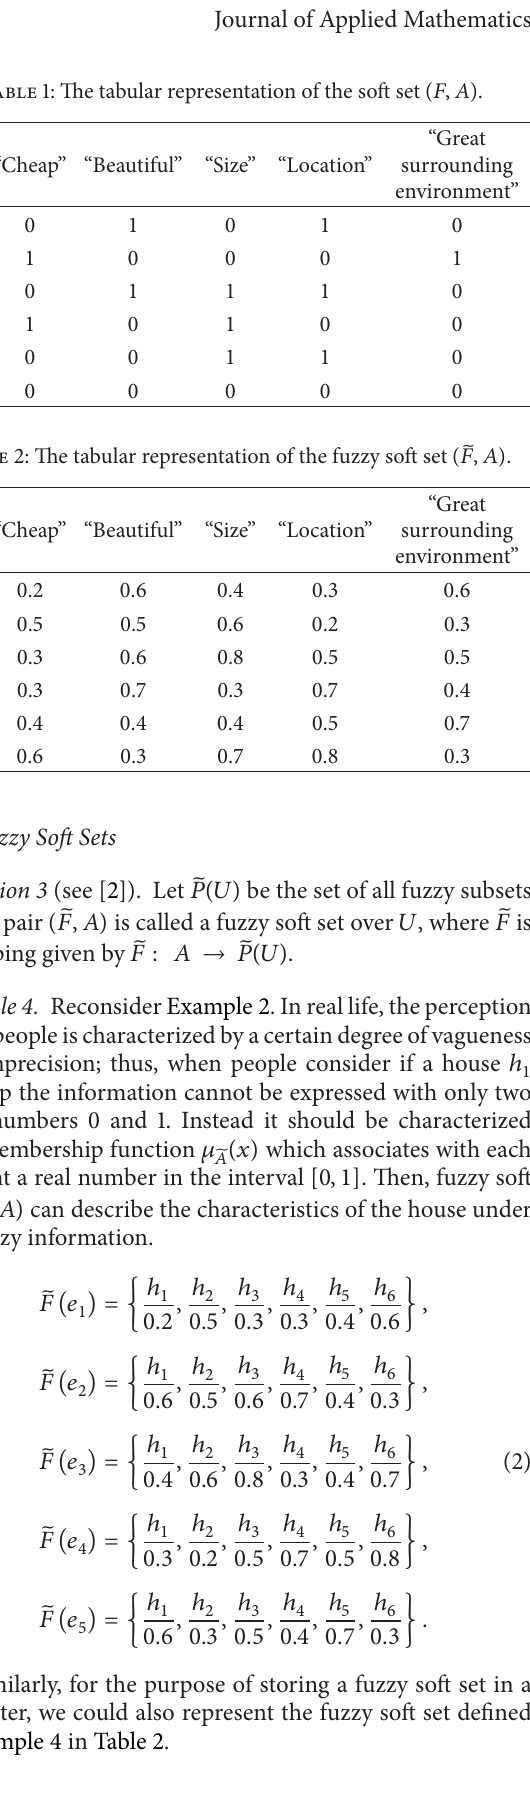
“Great surrounding environment”